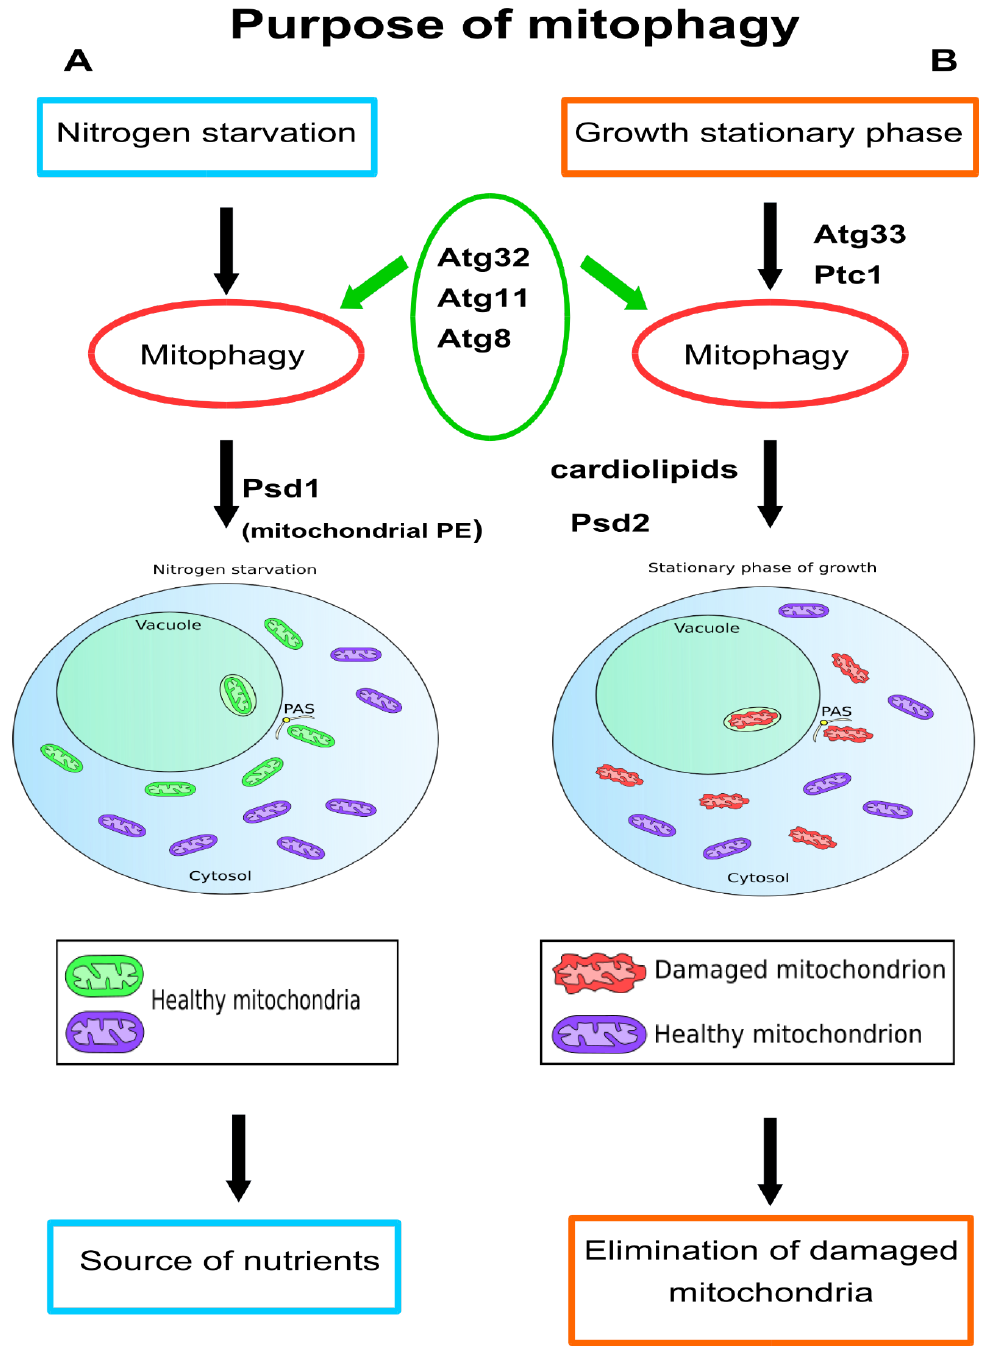
Figure 2. Mitophagy in yeast employs different signaling pathways in a context-dependent manner. In S. cerevisiae , mitophagy can be triggered by nitrogen starvation or stationary phase of growth. In each way, cells are cultured in media with respiratory carbon source and the process requires the same key proteins, such as Atg32, Atg11, and Atg8. ( A ) Cells submitted to starvation are harvested in a mid-exponential growth phase, and under these conditions most mitochondria are healthy and functional. Here, the role of mitophagy is to provide new nutrients by recycling redundant organelles to ensure cell survival in adverse conditions. ( B ) During the stationary phase of growth, mitophagy is useful to eliminate mitochondria that have been damaged or dysfunctional to maintain cellular function and homeostasis. The fact that proteins Aup1, Atg33, and Psd2 are required for the stationary phase mitophagy, but are indispensable for mitophagy induced by starvation, and conversely, that mitochondrial Psd1p is selectively required for the removal of mitochondria in nitrogen deficiency, suggests that different signaling pathways are involved in the induction of mitophagy